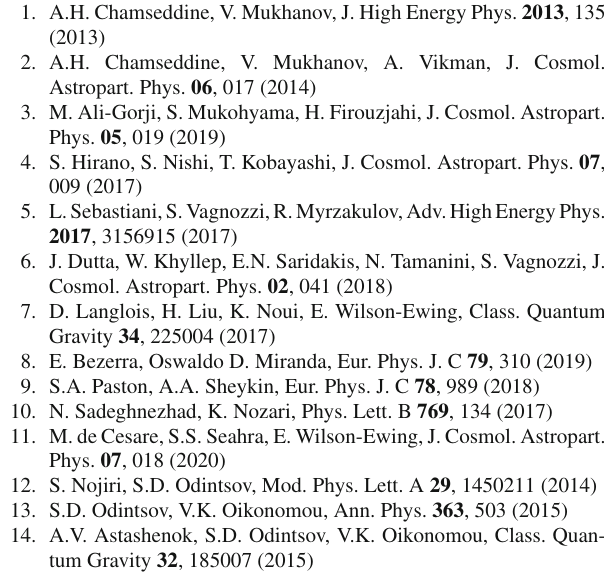
sitions or changes in the temperatures of the